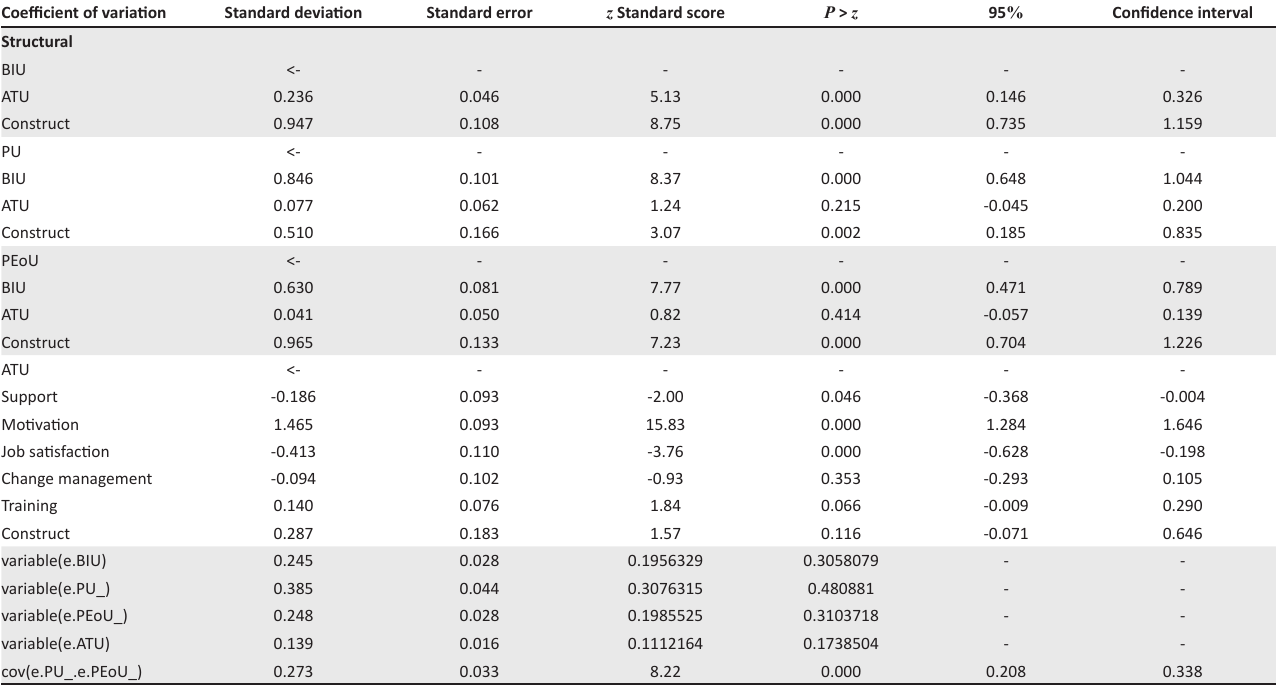
TABLE 5: Structural equation modelling factors that influence the effective utilisation of enterprise resources planning systems. Coefficient of